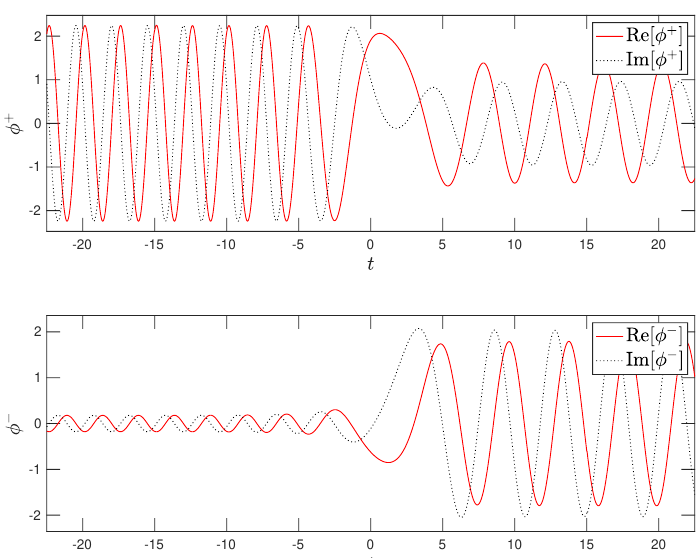
Figure 3. Shown are the real and imaginary parts of the exact free mode functions (cid:30) (cid:6) (1) in equation (3.17a), across the transition de(cid:12)ned by the mass pro(cid:12)le (3.15). We used the initial conditions (3.21) and the same parameters as in (cid:12)gure 2a with